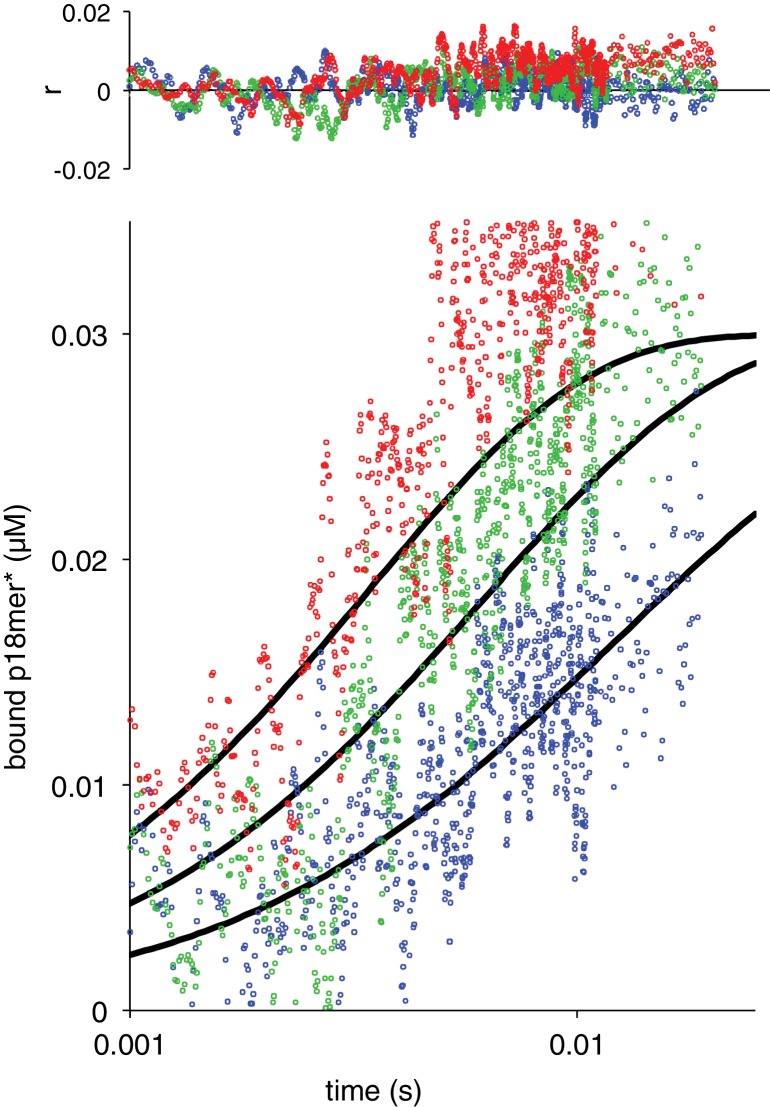
Association of ΔWGR with p18mer*.Global fits of the kinetic model in Scheme 1 for three representative protein concentrations: 37 nM in blue, 74 nM in green, 129 nM in red. Residuals for the three concentrations are shown overlaid in the corresponding colors above.10.7554/eLife.37818.013Figure 2—figure supplement 4—source data 1.Association of ΔWGR with p18mer*.